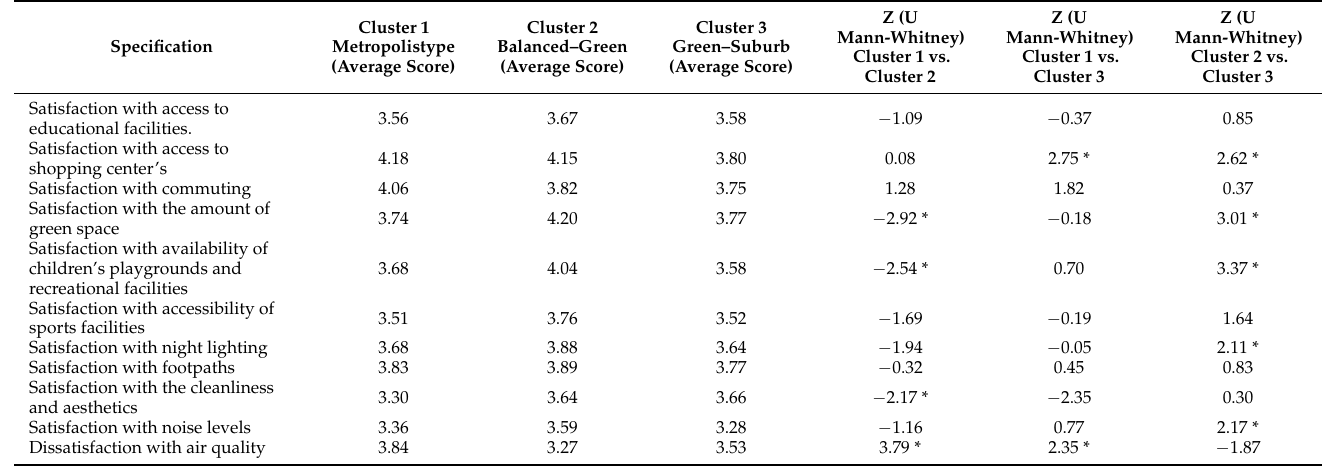
Table 10. Level of satisfaction with urban infrastructure in clusters with different characteristics in terms of amount of green space (Mann-Whitney U test for pairs of